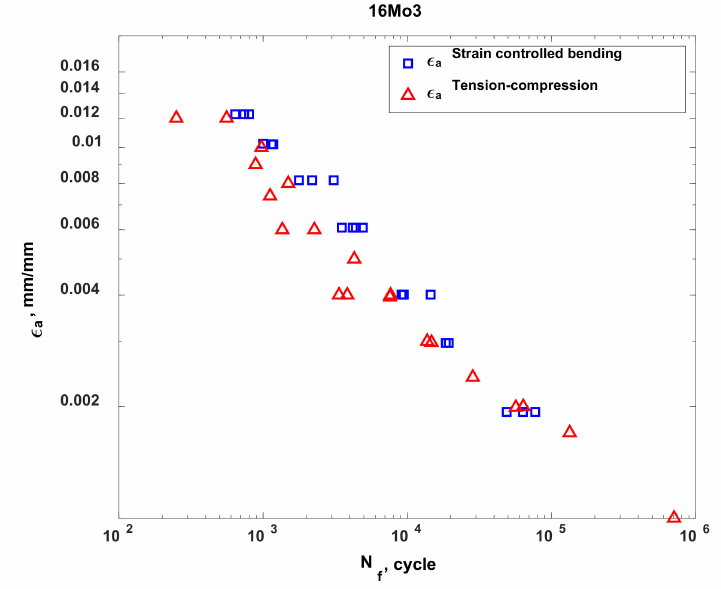
Figure 4. Dependence of strain amplitudes on the number of